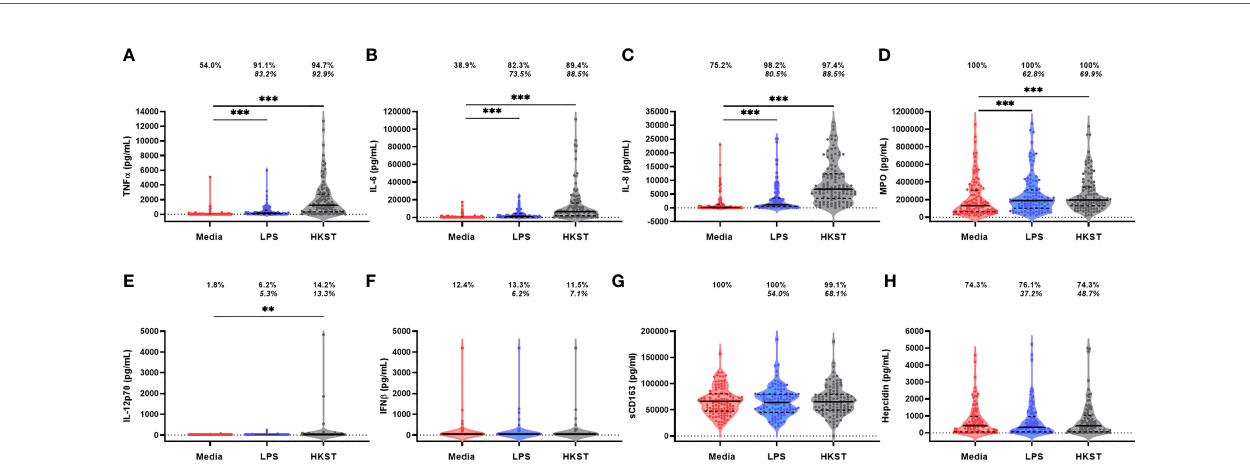
FIGURE 2 | Soluble mediator production by blood immune cells from 18-month-old Zimbabwean children in response to in vitro bacterial antigen challenge. Violin plots (median and interquartile range indicated) of (A) TNF a ; (B) IL-6; (C) IL-8; (D) MPO; (E) IL-12p70; (F) IFN b ; (G) sCD163; and (H) hepcidin concentrations (pg/ mL) present in supernatants from parallel 24h culture of whole blood samples from Zimbabwean children with culture media only (unstimulated; red), LPS (blue) and HKST (grey). Proportions indicate participants with mediator concentration > ELISA limit of detection; proportions in italics indicate participants with mediator concentration > unstimulated. Log-transformed mediator concentrations were compared between culture conditions using generalised estimating equations (n = 113); **p < 0.01, ***p <